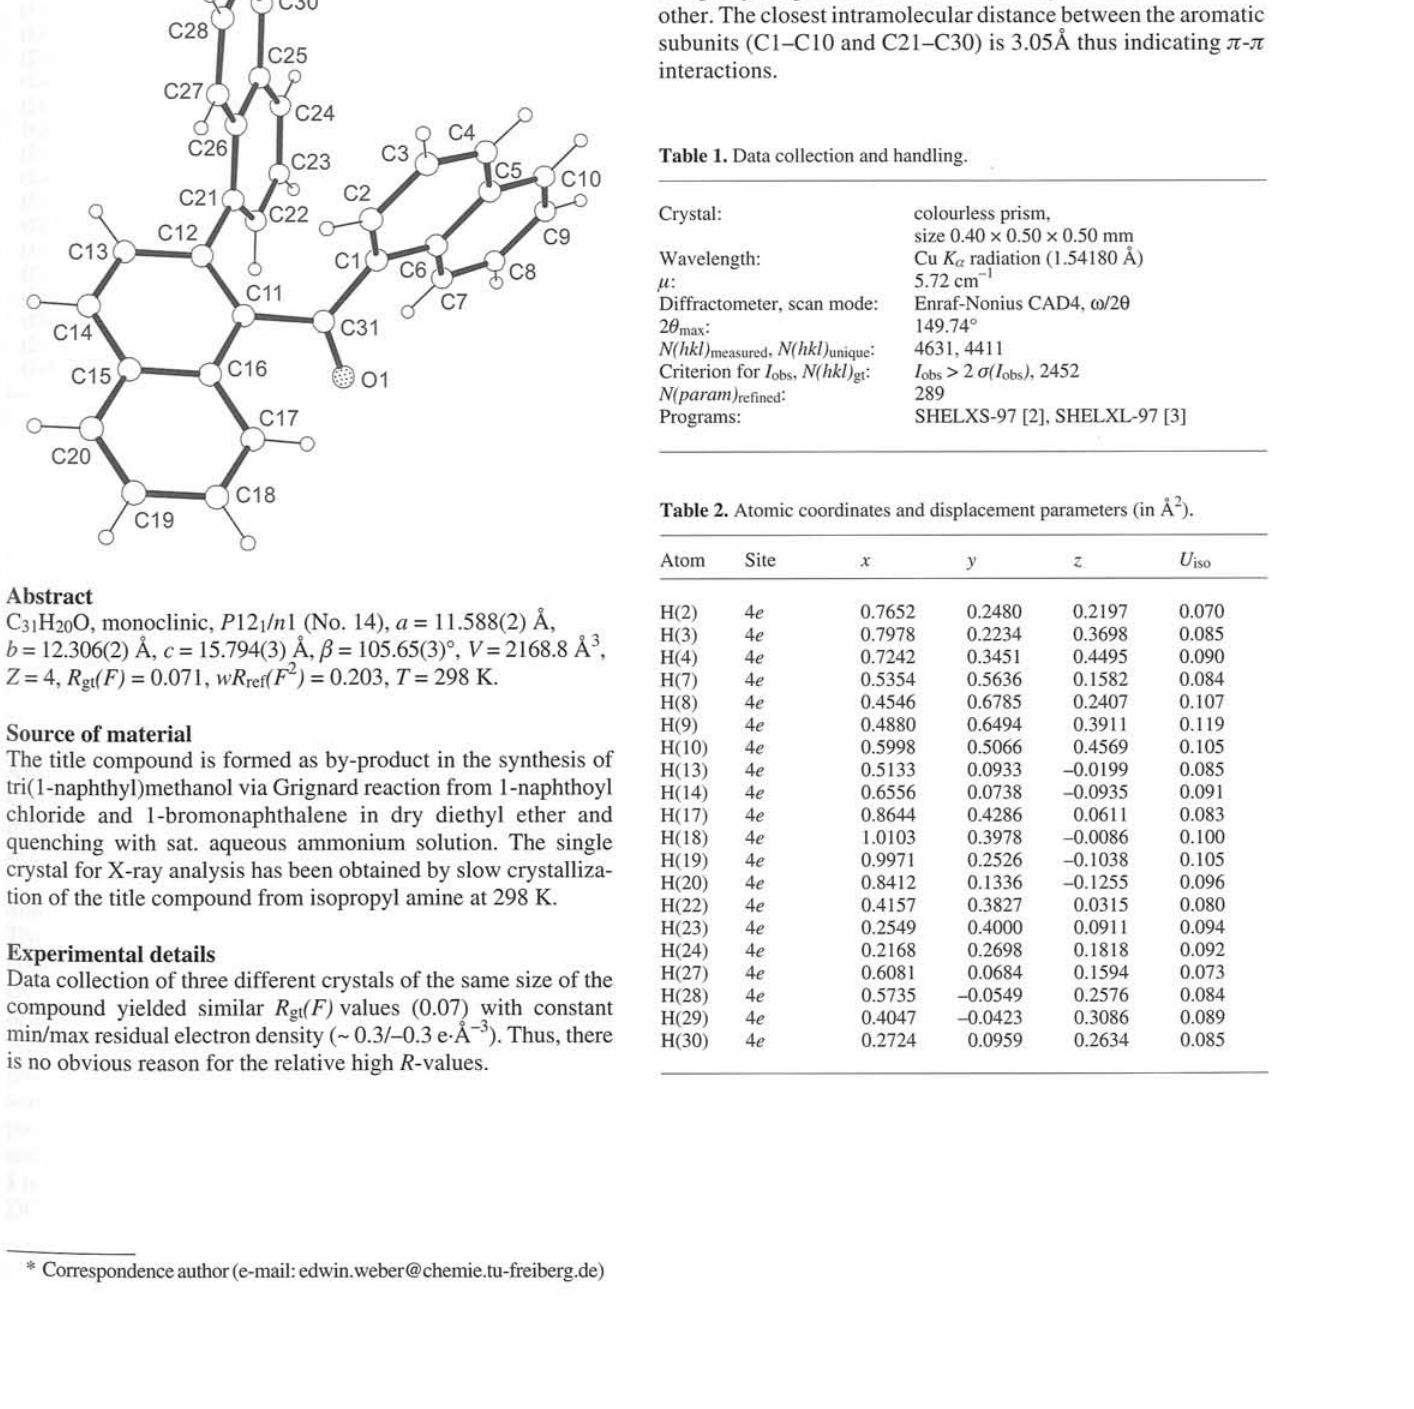
Table 1. Data collection and handling.